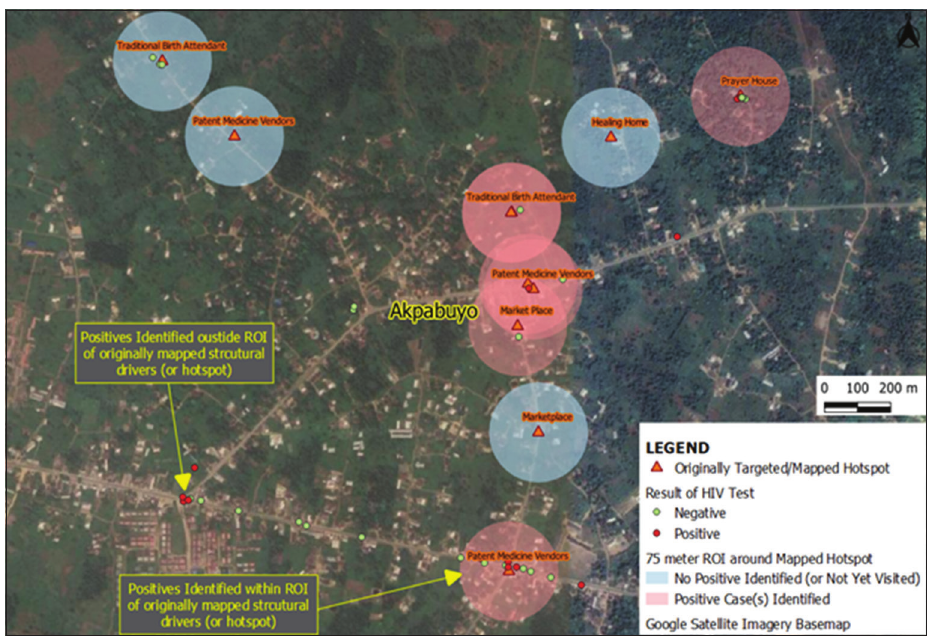
FIGURE 1. Sectional map of Akpabuyo LGA, Cross River State showing originally targeted “Hotspots.”